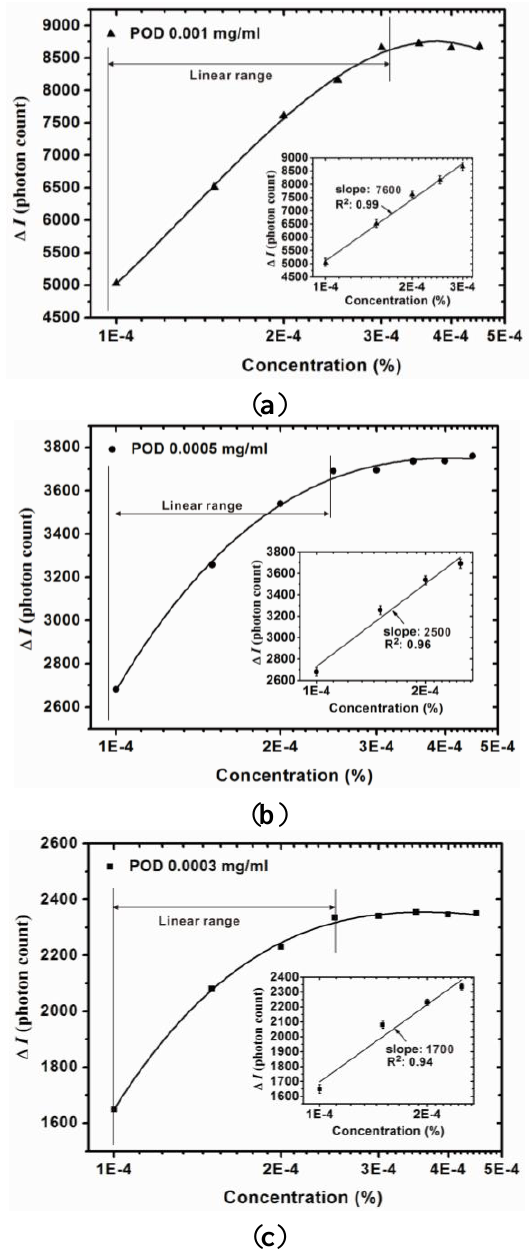
Figure 6. Calibration curve of proposed sensor with various POD concentrations (( a ) 0.001 mg/mL; ( b ) 0.0005 mg/mL; and ( c ) 0.0003 mg/mL) at a monitored wavelength of 450